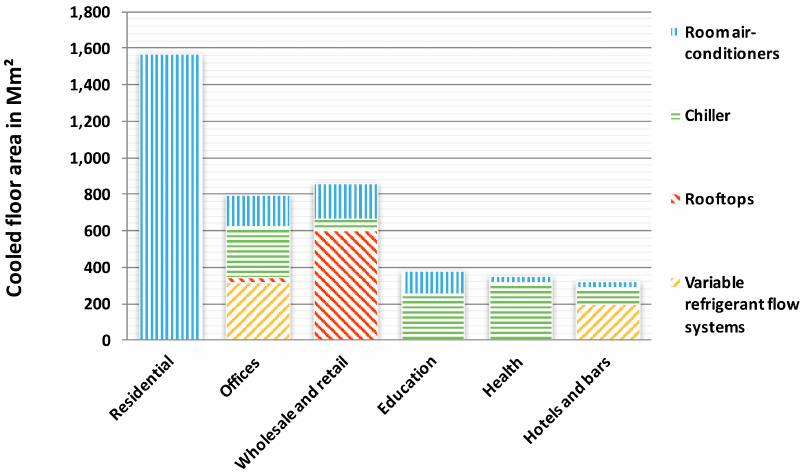
Figure 9. Distribution of cooled floor area per sector and AC type, EU15 (see references in the Appendix A, Table